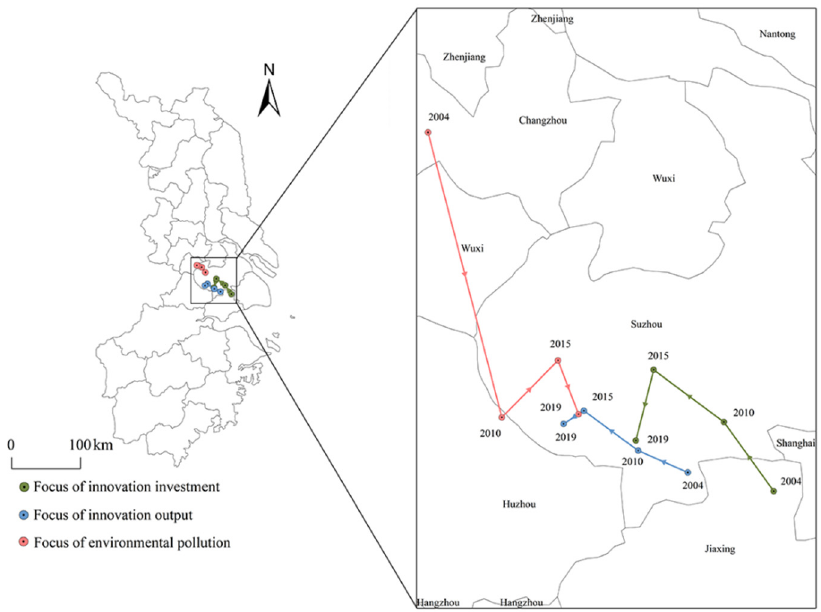
Figure 6. The migration trajectory of the center of technological innovation and the center of water pollution in the Yangtze River Delta.